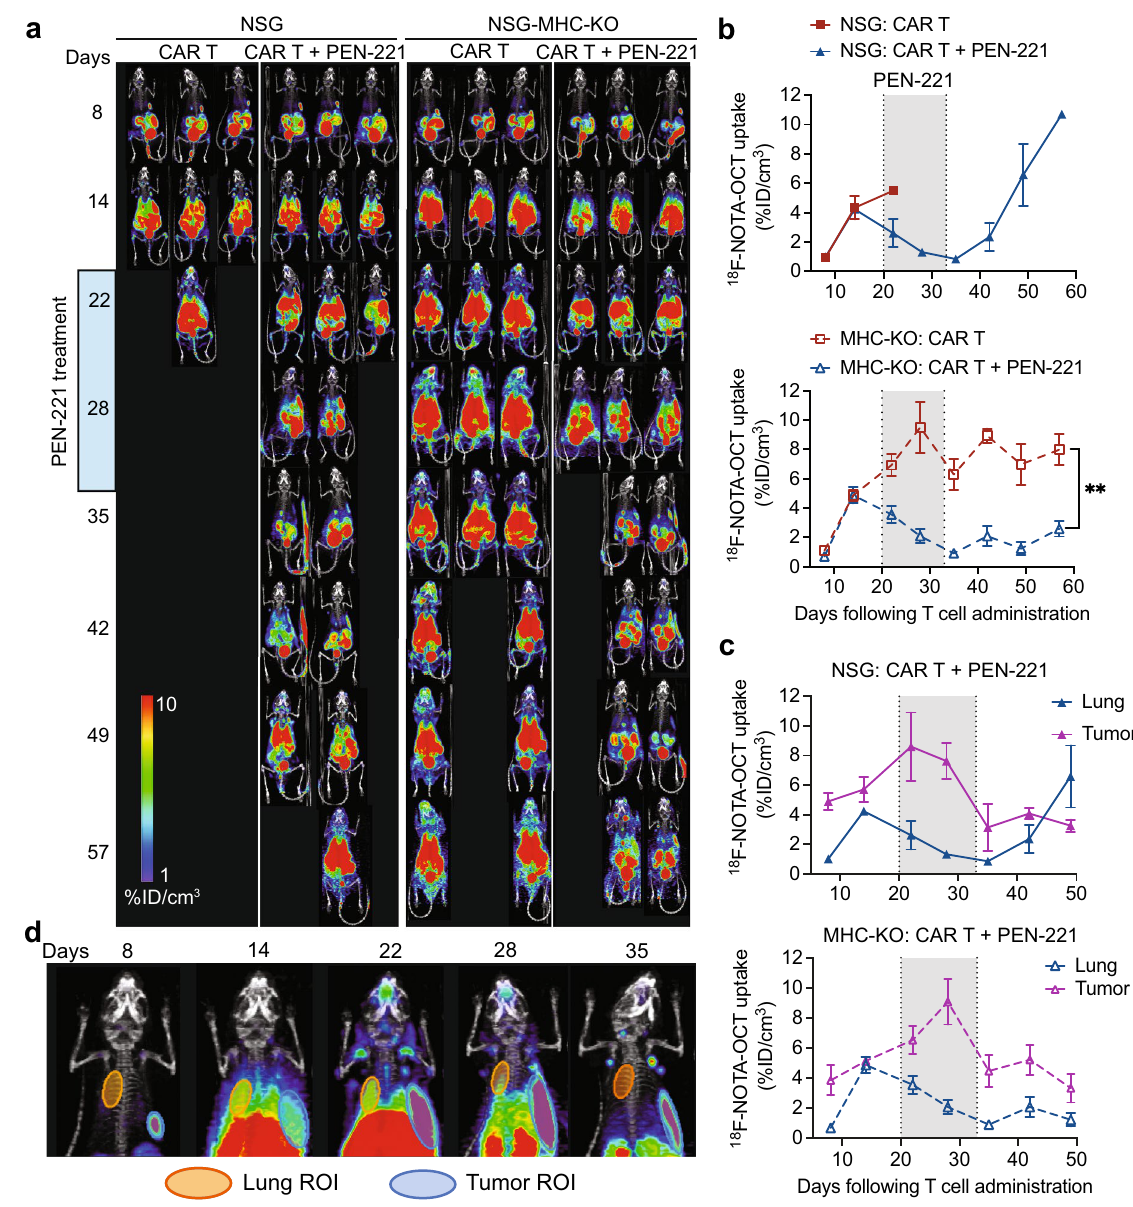
Figure 4. PET/CT imaging using 18 F-NOTAOCT reveals rapid clearance of CAR T cells by PEN-221. ( a ) PET/ CT imaging showing CAR T cell expansion and contraction. Images are maximum intensity projections of the entire mouse body. ( b ) Systemic expansion of CAR T cells was estimated by 18 F-NOTAOCT update in the lungs. Data represent mean ± SD of 3 mice per cohort. A two-way ANOVA with Tukey’s multiple comparisons test was used for statistical analysis. **, P < 0.01. ( c ) Comparison of CAR T cell expansion and elimination in the lungs and tumors. ( d ) Representative magnified PET images (mouse# 3 in NSG-MHC-KO: CAR T + PEN-221 cohort). Region of interests (ROIs) for the lungs and tumors are shown as yellow and blue